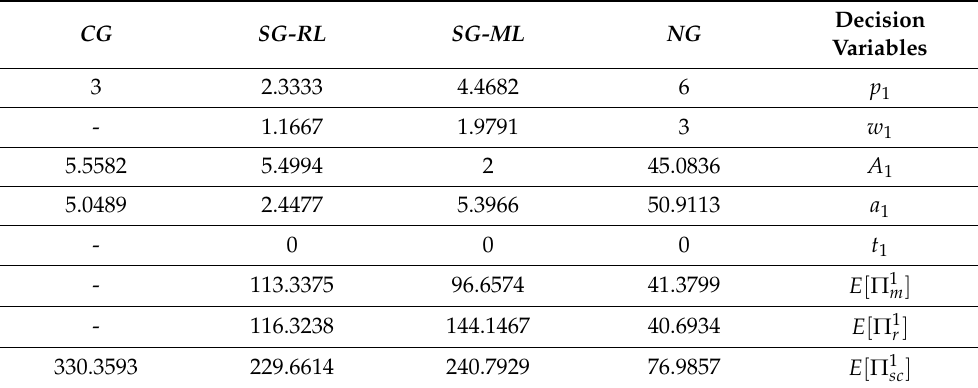
Table 5. The results for the numerical example 2 in the first model.